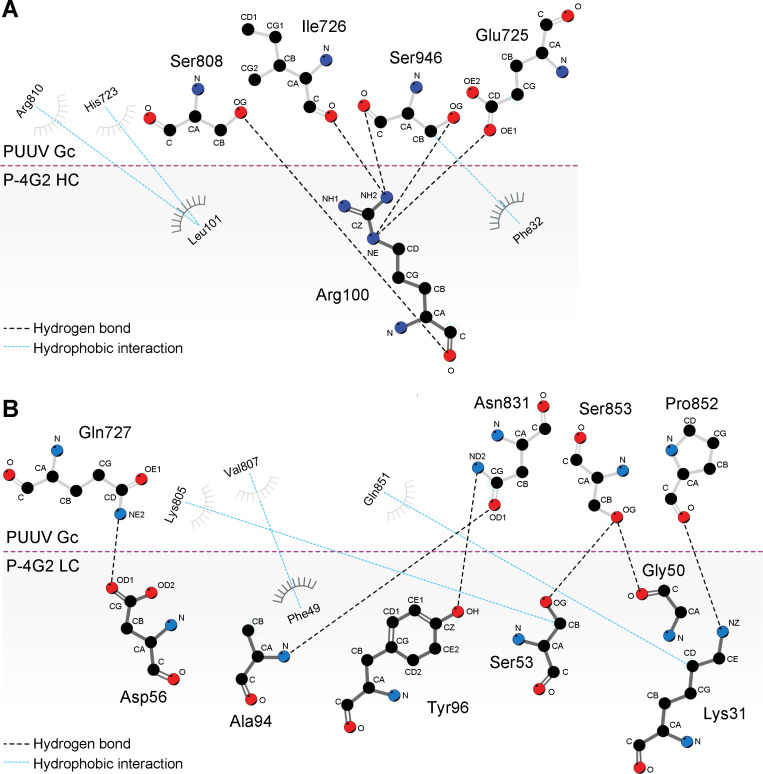
Key interactions at the Fab P-4G2−Puumala virus Gc complex interface.Paratope and epitope residues involved in hydrogen bonding (dashed black lines) for contacts made by the heavy (A) and light (B) chains were identified using the PDBePISA server (Krissinel and Henrick, 2007). Residues involved in hydrophobic interactions (dashed blue lines) were identified with LigPlot+ (Laskowski and Swindells, 2011). The interface was visualized using LigPlot+. Residues contributing to hydrophobic interactions are shown as curved lines with dashes. Atoms in residues participating in hydrogen bonding are depicted as circles, with oxygen in red, carbon in black, and nitrogen in blue.